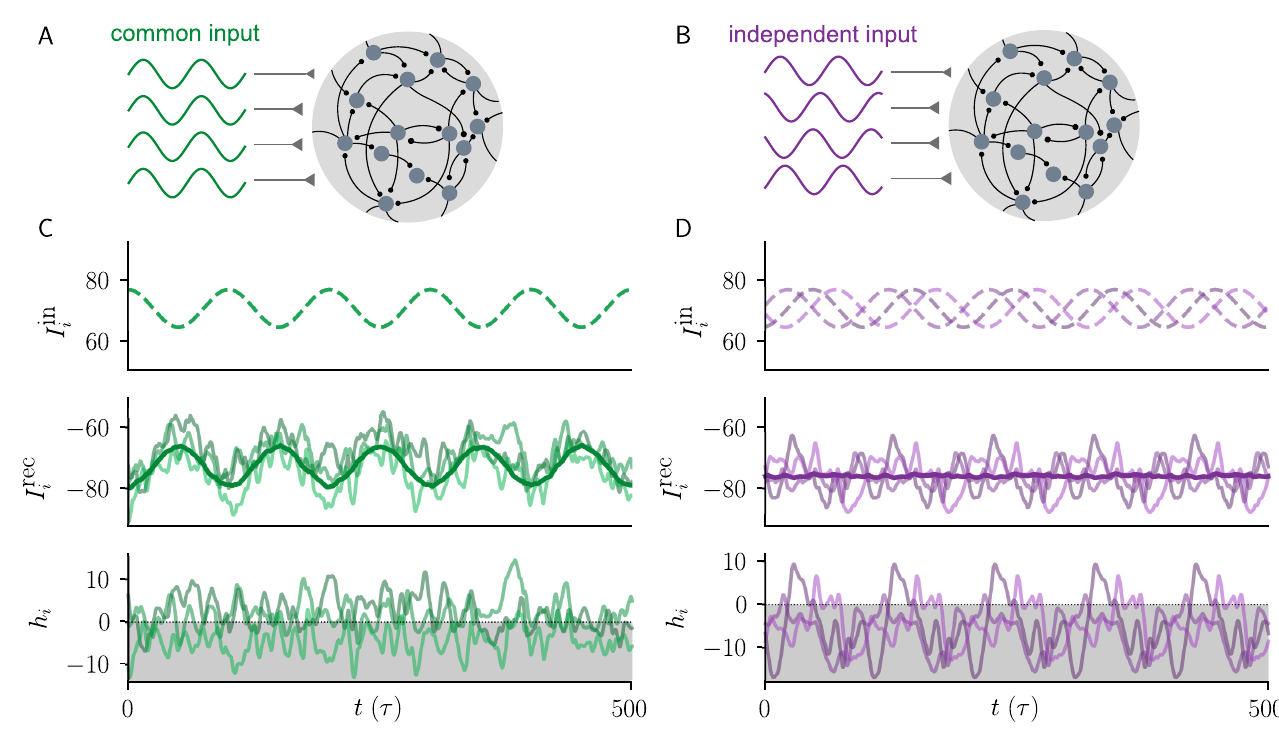
ffiffiffiffi p ð t Þ ¼ N I 0 þ d I ð t Þ consist of a ffiffiffiffi p i ð t Þ ¼ ð t Þ N I 0 þ d I i i ¼ i